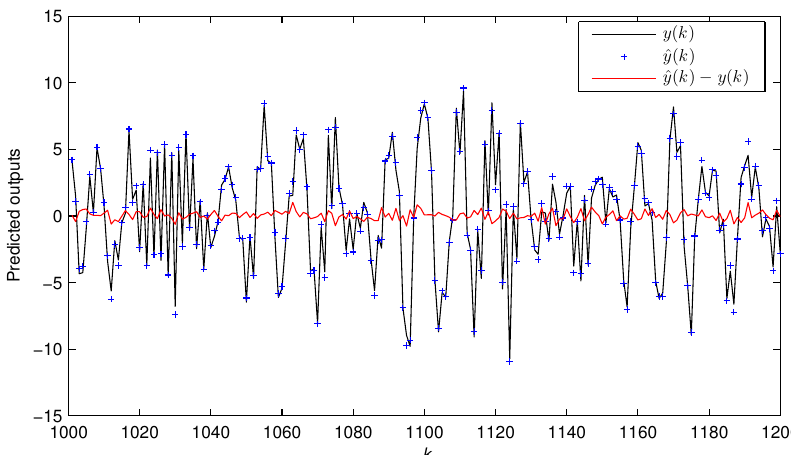
Figure 12. The actual output y ( k ) and the estimated output ˆ y ( k ) versus k for Example